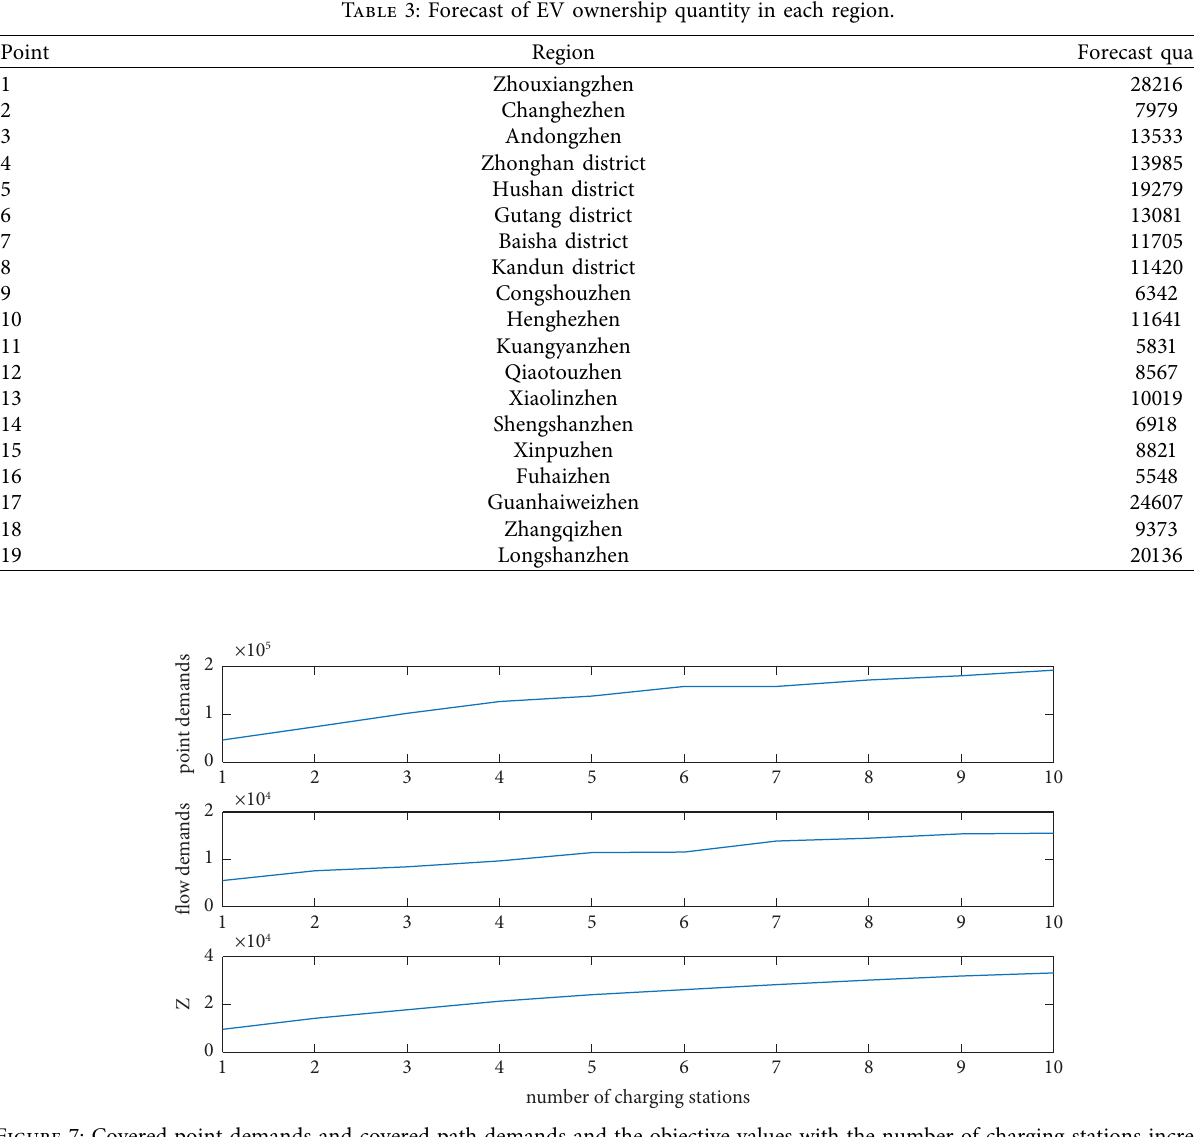
Figure 7: Covered point demands and covered path demands and the objective values with the number of charging stations increasing under θ � 0.1.